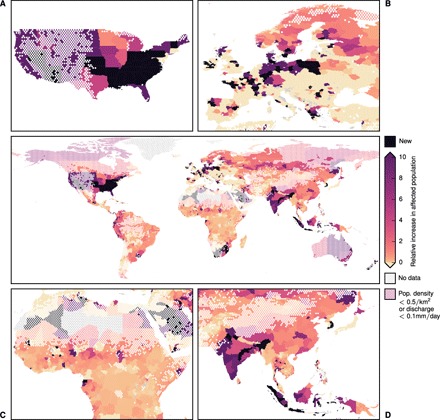
Relative increase in affected people without adaptation measure (realization ensemble median).Increase is given as the multiple of change between future and historic periods relative to the historic period. A value of 2 means that three times as many people are at risk of high-end river flooding during 2035 to 2044 compared to 1971 to 2004. Regions with affected population in the future period, but none in the historic one, are marked “new” (black). Subfigures show regional foci on the (A) United States, (B) Europe, (C) Africa, and (D) Southeast and East Asia. Decrease in affected population is cut off to 0. Pop. density, population density.